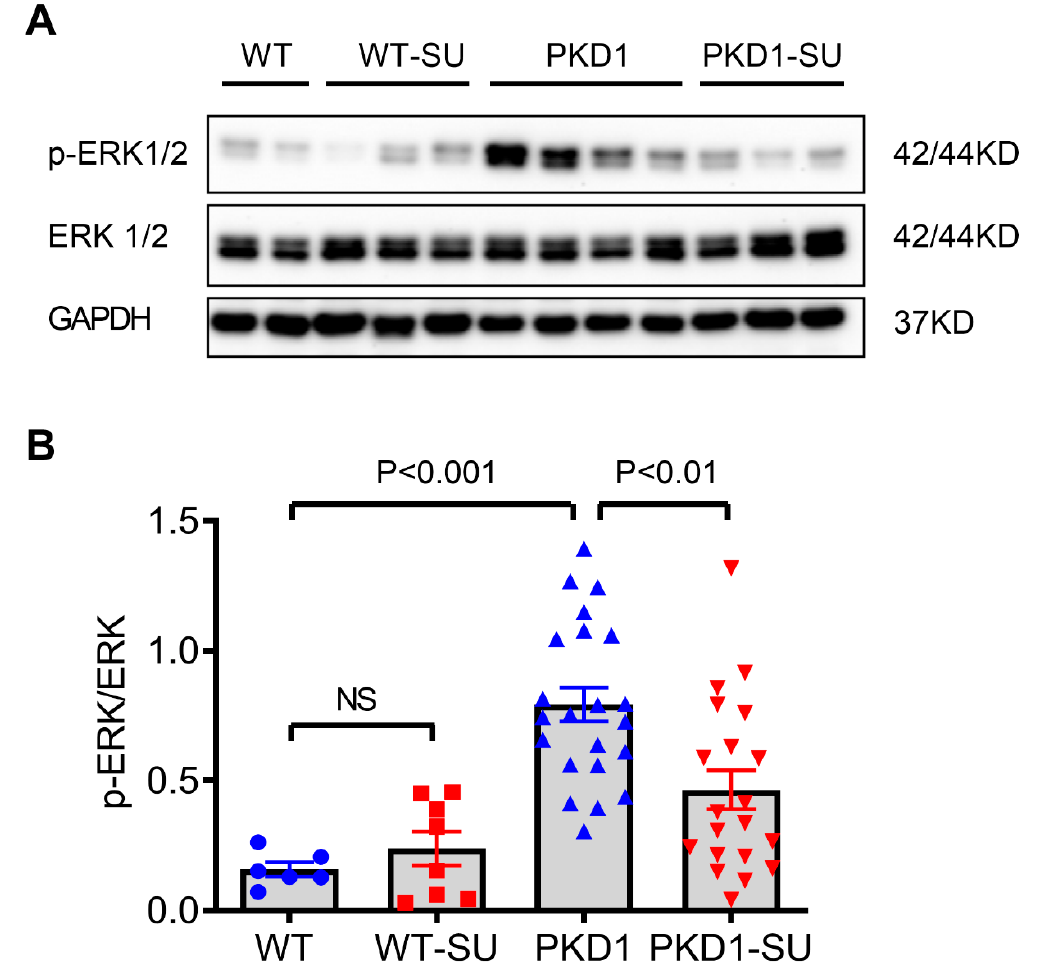
Figure 6. Suramin reduces the phosphorylation of ERK1/2 in Pkd1- miR Tg mice. Kidney lysates from Pkd1- miR Tg mice and wild-type mice with or without suramin treatment were analyzed by Western blotting analysis. ( A ) Representative immunoblots of phosphorylated ERK1/2, total ERK1/2, and GAPDH. ( B ) The densitometric analysis of p-ERK1/2 normalized to total ERK1/2 protein expression. GAPDH was used for loading control. Data are mean ± SEM (n = 6, 8, 22, and 20 per group respectively).